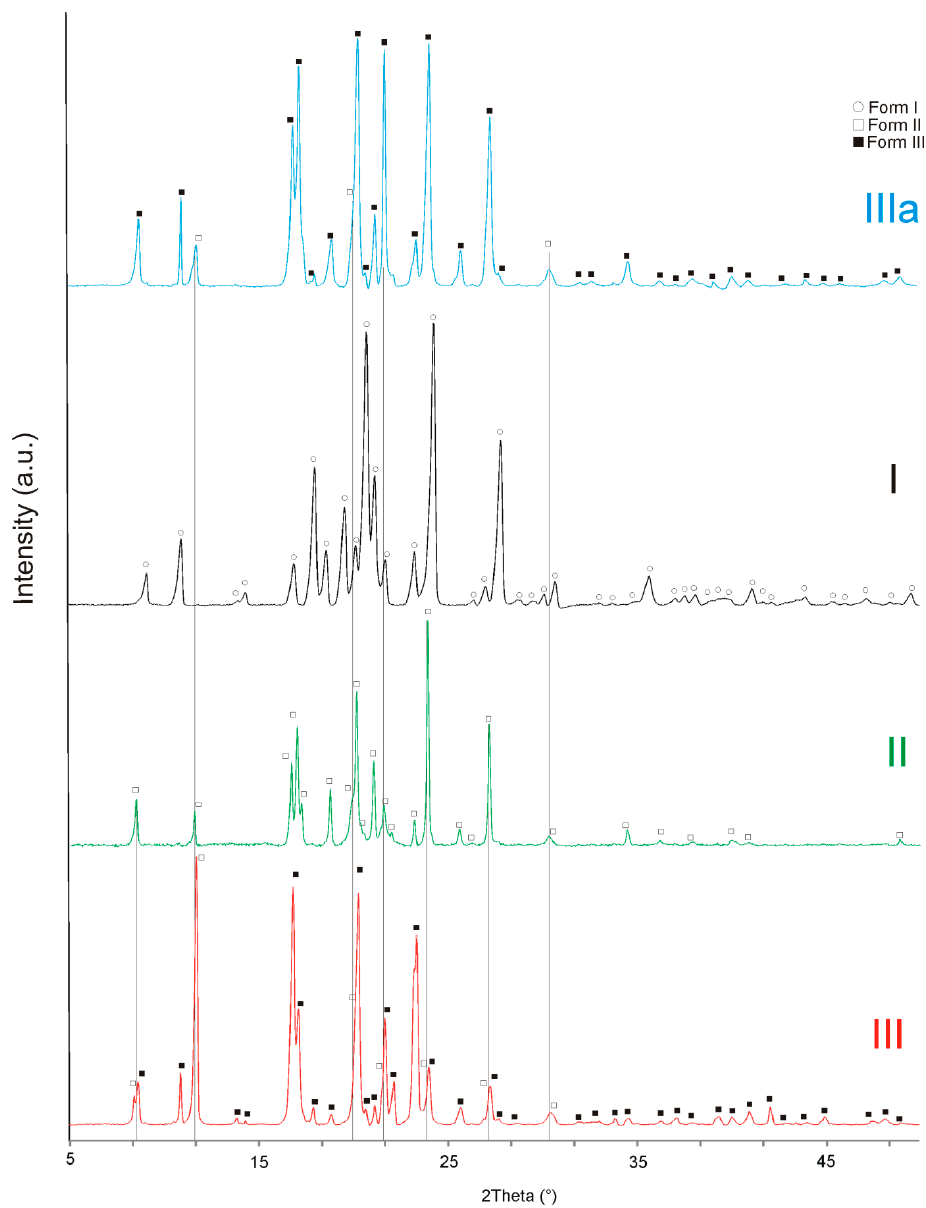
Figure 1. PXRD diffractograms of polymorphic forms of benzocaine.